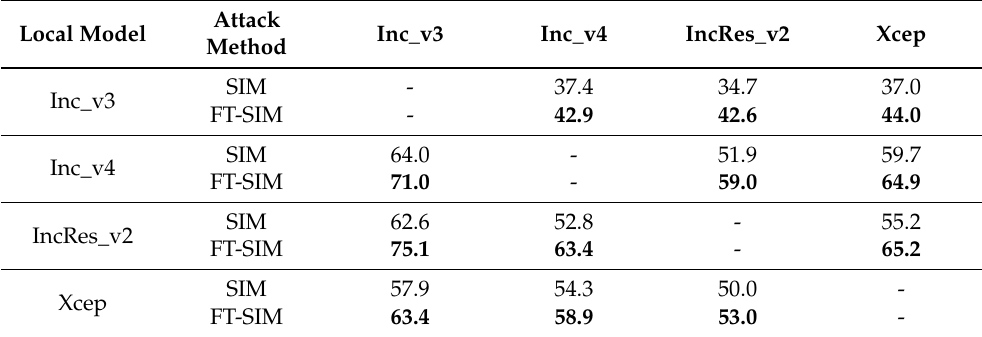
Table 3. The black-box ASRs of SIM and FT-SIM on ImageNet. The first column is the local model, and the first row is the target model. The values in the table are the ASRs (%) on the target models using the adversarial examples generated with the local models. The higher ASRs are shown in